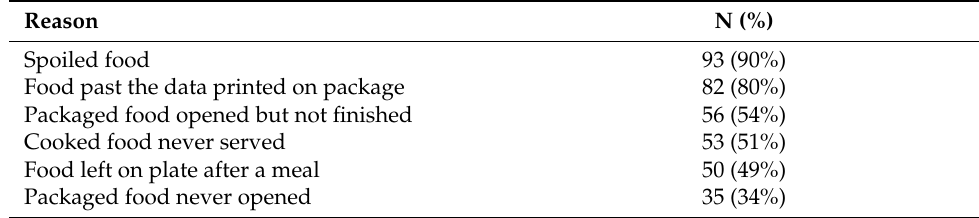
Table 3. Number and percent of participants reporting specified reasons for food waste ( n = 109 *).